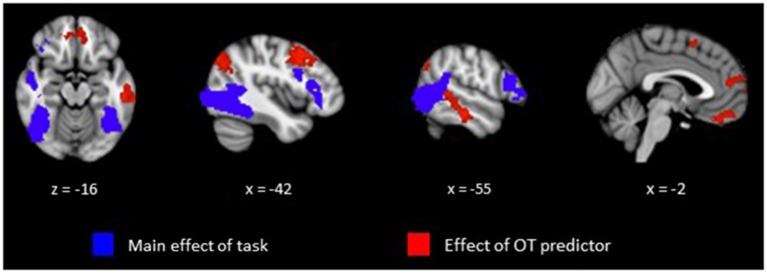
Clusters representing positive activations from the Animate vs. Random contrast from whole-brain analysis with cluster thresholding. Activations in blue represent positive task-related activity for Animate relative to Random motion trials. Activations in red represent regions that show a significant relationship between level of plasma OT and positive task-related activity for Animate relative to Random motion trials.